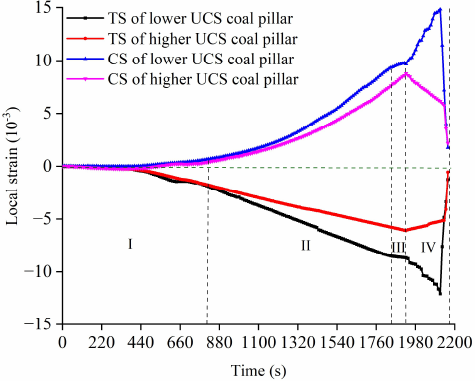
Figure 7. Local strain of serial coal pillar specimens with different